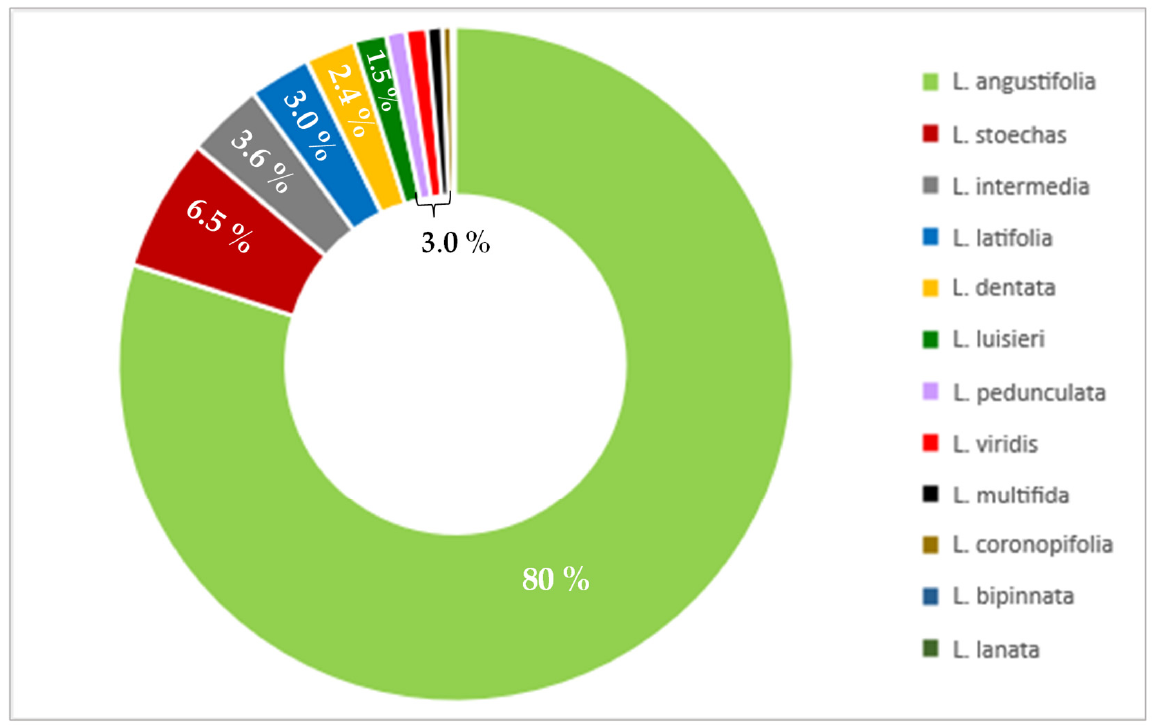
Figure 2. Percentage of publications for various lavender species in the last 25 years (PubMed, November 2022).